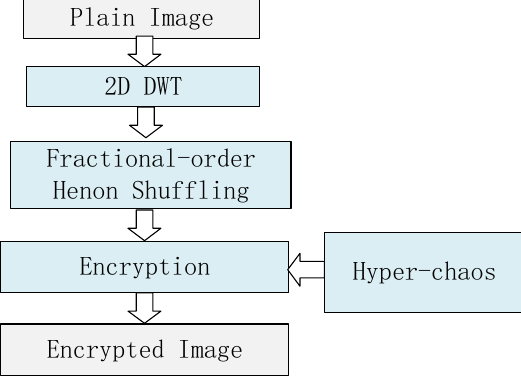
Figure 9. The block diagram of the image encryption algorithm.